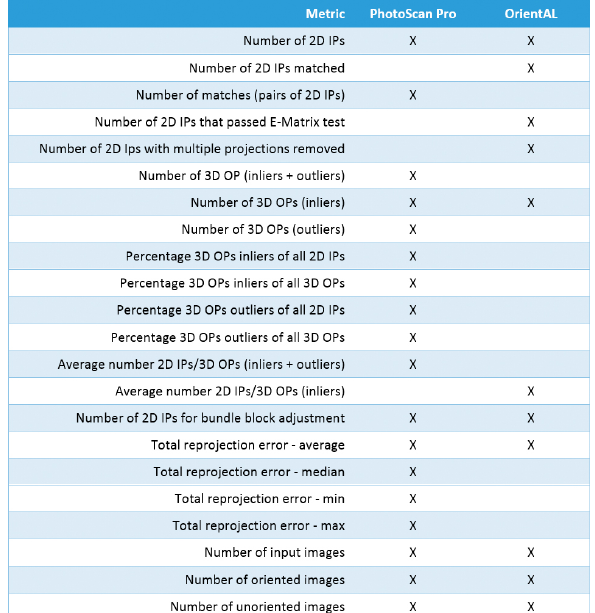
Table 3. Some of the metrics computed by both SfM packages.